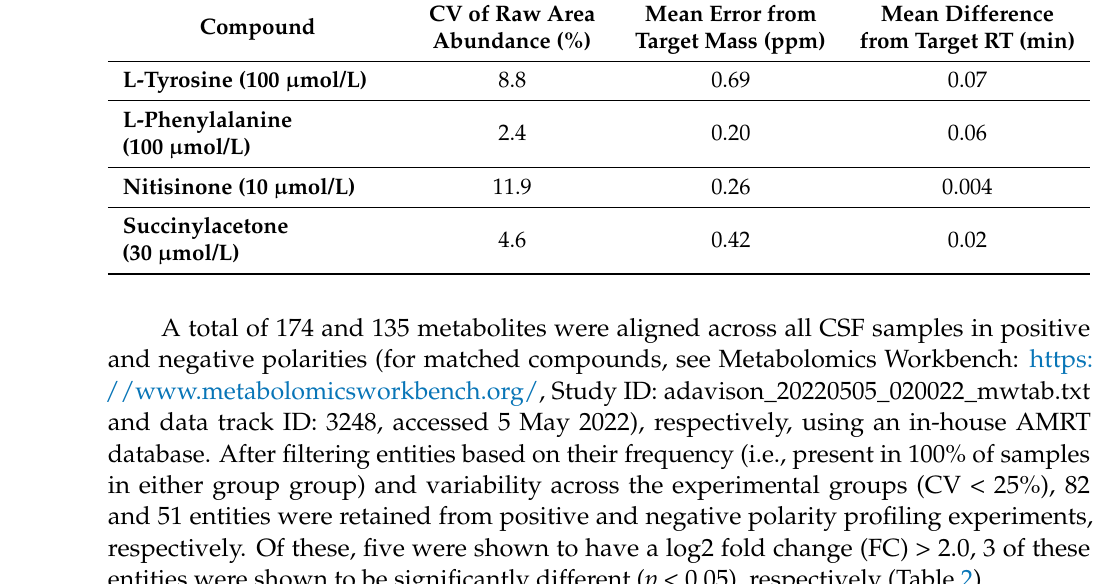
Table 2. CSF metabolite changes identified post-nitisinone therapy in BALB/c Hgd − / − mice using an in-house AMRT database. Abundance expressed as log2 FC, compared to BALB/c Hgd − / −